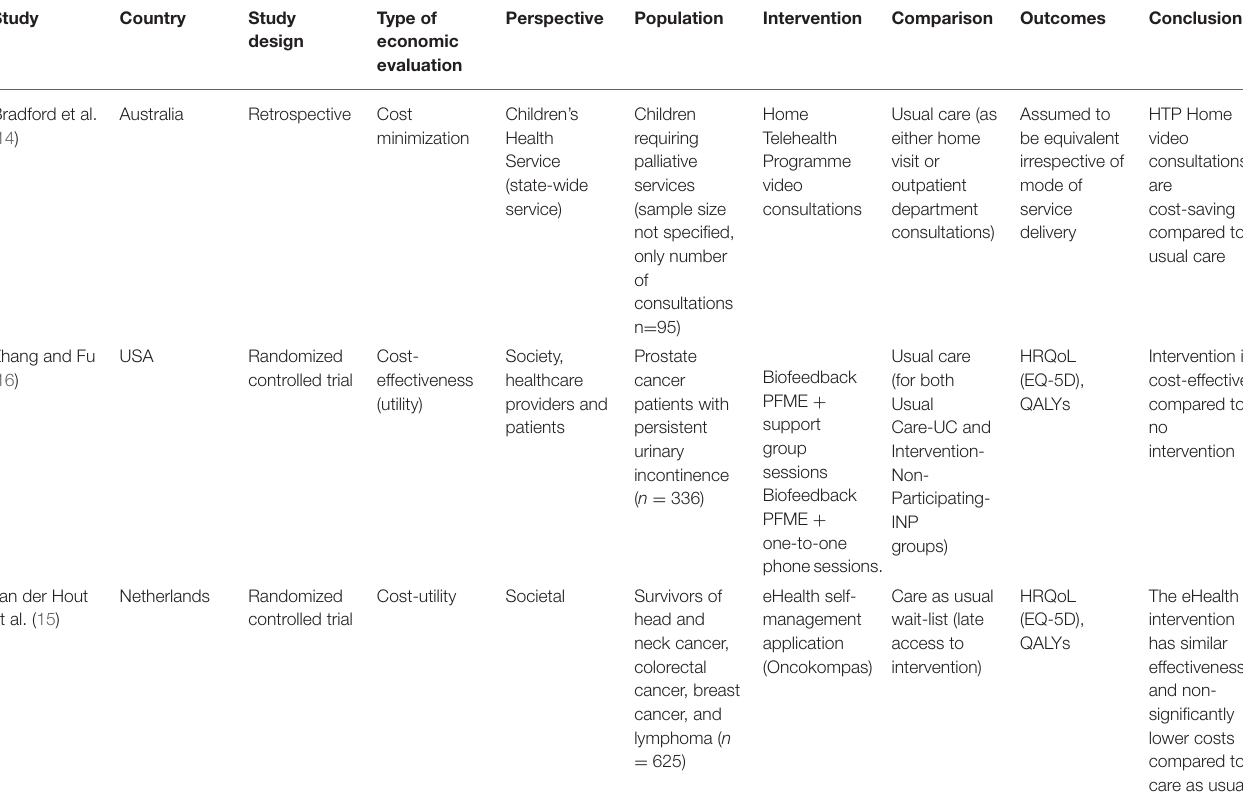
TABLE 2 | Table of included studies.